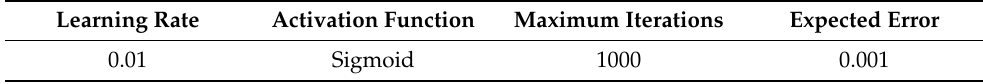
Table 5. Initial parameters of BP neural network.